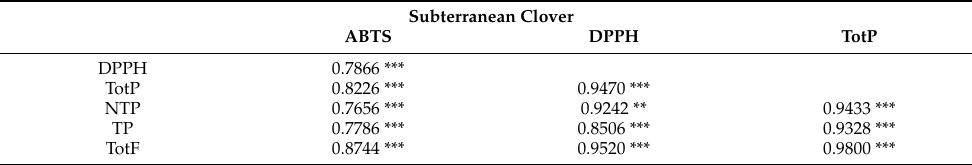
Table 4. Correlations ( R 2 ) established between total phenolics (TotP), non-tannic phenolics (NTP), tannic phenolics (TP), total flavonoids (TotF) and antioxidant capacity (ABTS, DPPH) in Trifolium subterraneum